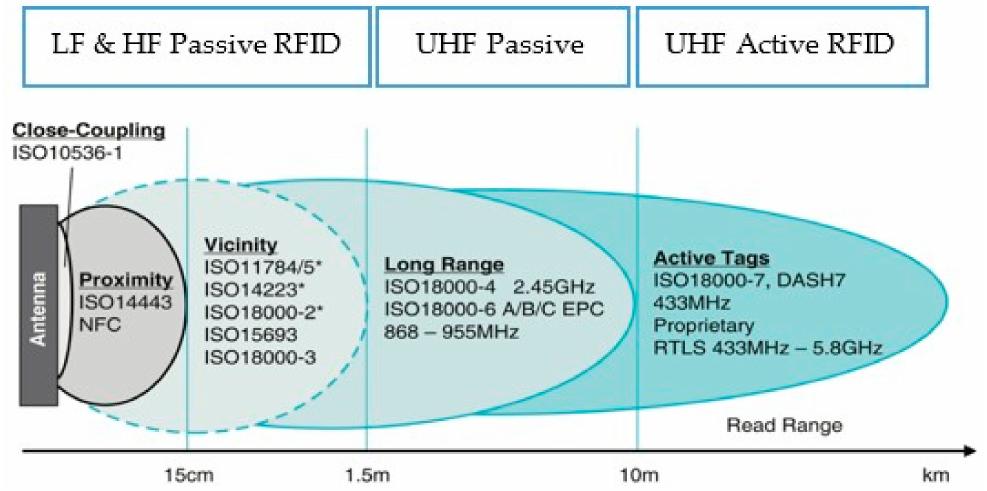
Figure 2. Distribution of RFID technologies in terms of reading device range and frequency (* 125–134 kHz); Source: